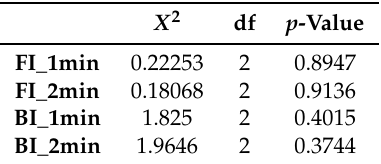
Table 17. Kruskal–Wallis rank sum